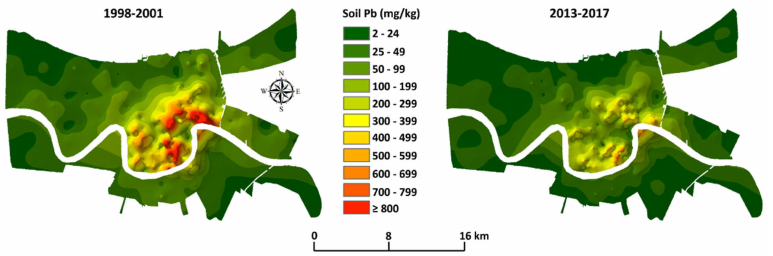
Figure 6. The spatiotemporal declines in soil Pb and blood Pb are presented in Figure 7.